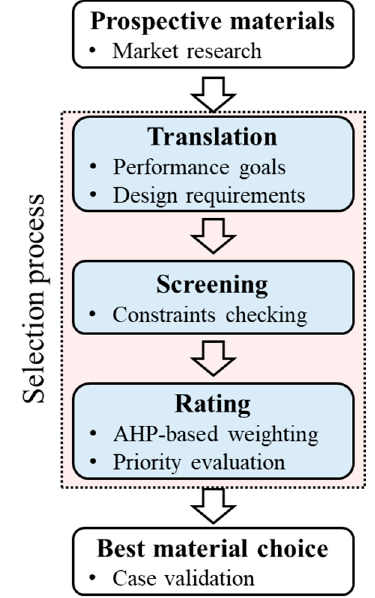
Figure 1. Material selection process for construction materials.